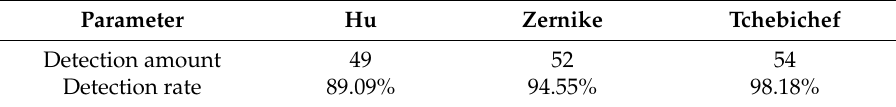
Table 3. Detection rate of the testing sample set in the first